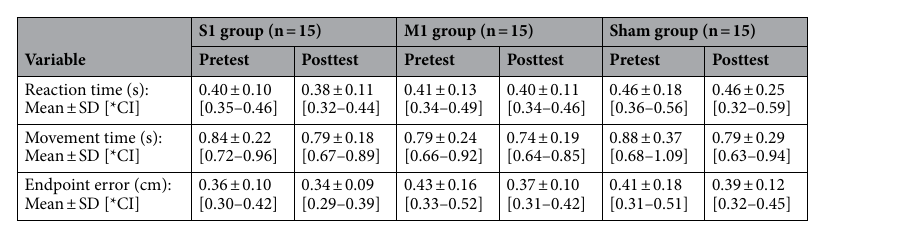
Table 1. Means, standard deviations and confidence intervals of reaction time, movement time and endpoint error of the motor task for stimulation groups in time points. S1/M1 group: high-definition transcranial direct current stimulation over S1/M1, respectively. *CI = 95% confidence interval.